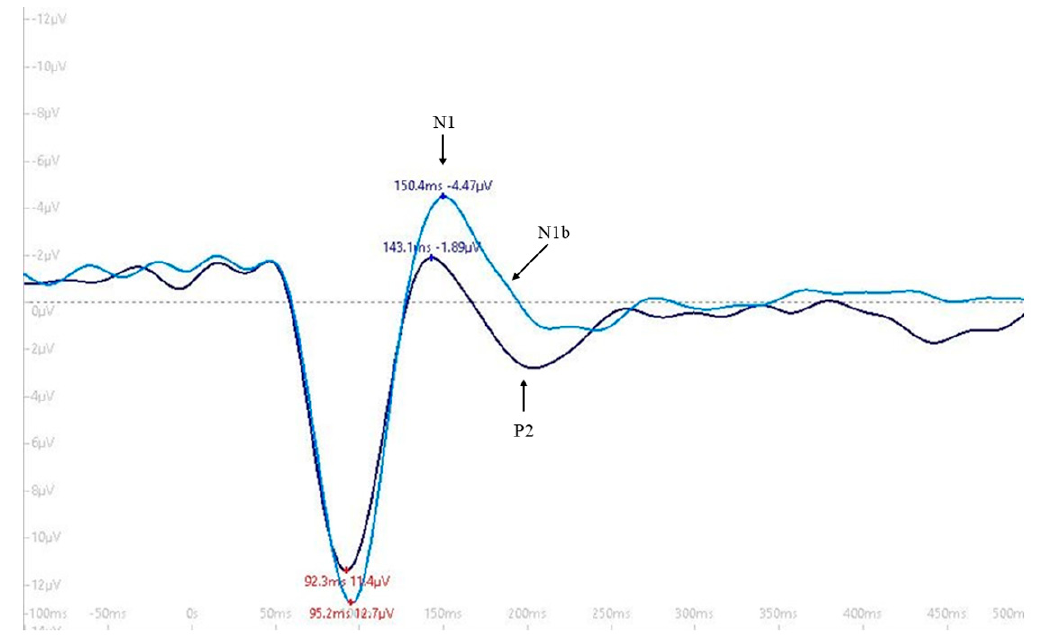
Figure 3. Visually evoked potential N1b waveform. Amplitude of the N1b component was defined as the mean amplitude of the section of the evoked potential, extending from the peak of the N1 component to halfway between the N1 and P2 components. N1b change was calculated by subtracting pre-tetanus N1b amplitude (dark blue line) from early (light blue line) and late post-tetanus.